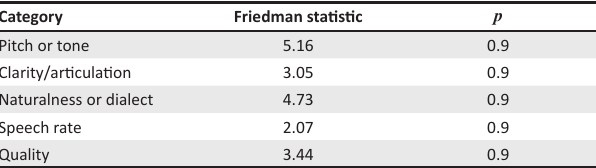
TABLE 2: Friedman analysis of variance analyses comparing raters within each rating category.